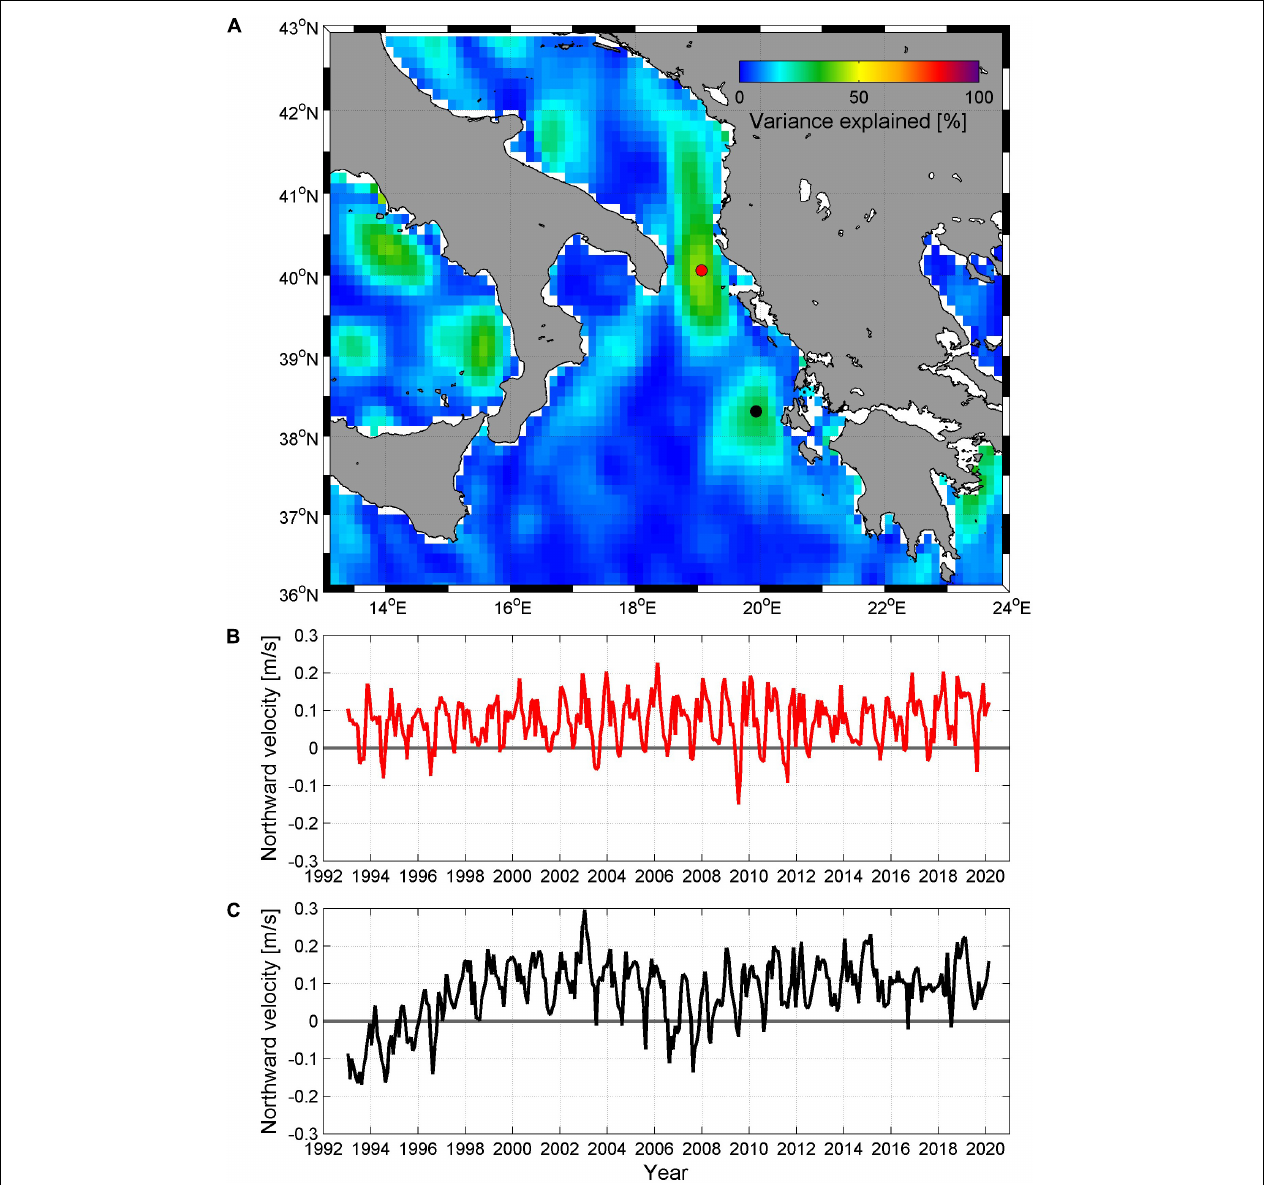
FIGURE 10 | (A) Percentage of total geostrophic velocity variance explained by the seasonal signal, with two grid points denoted by red (Otranto Strait) and black (west of Cephalonia Island, Greece). (B) AVISO + northward monthly geostrophic currents at the Otranto Strait grid point. (C) AVISO + northward monthly geostrophic currents at the grid point west of